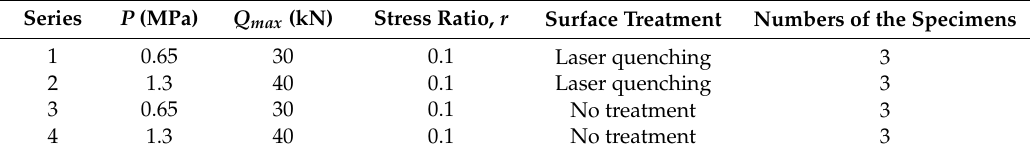
Figure 8. Load configuration of the fretting test. Table 3. Experimental parameters used in fretting fatigue